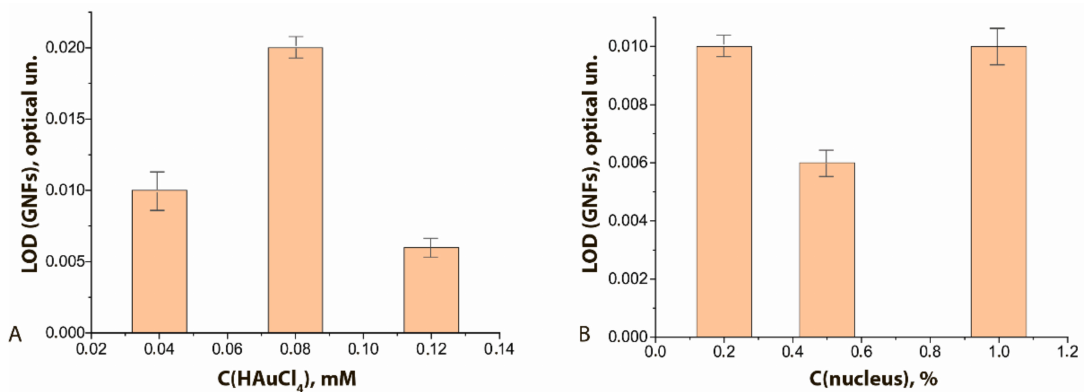
Figure 7. LODs of functional characterization of GNFs–Ab6/FABP conjugates by ELISA method: ( A ) influence of the C(HAuCl 4 ); ( B ) influence of the C (nuclei). C(Ab6/FABP) was equal to 10 µ g/mL.